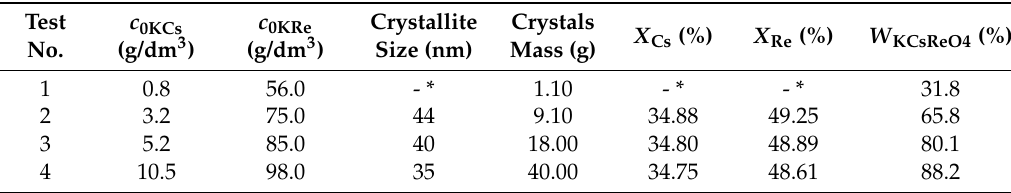
Table 8. Impurity contents in crystallised CsReO 4 .